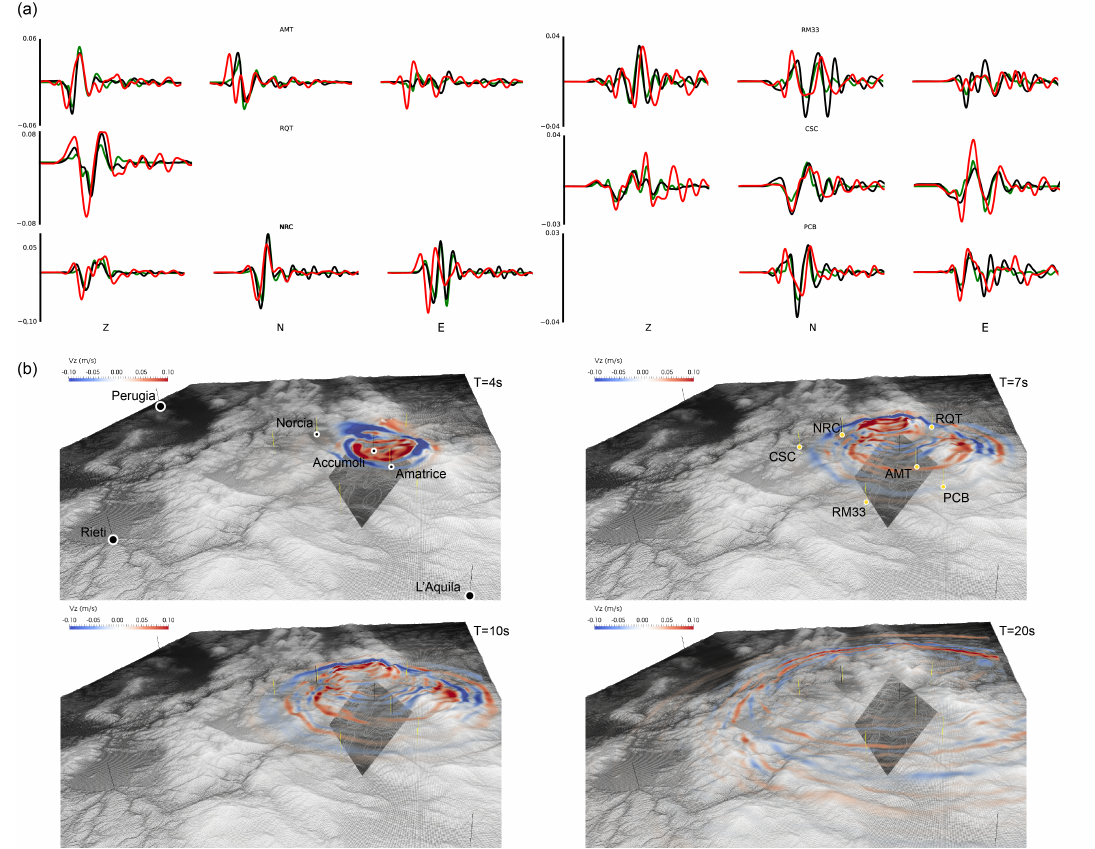
Figure 2: a) Velocity history at selected stations (AMT, RQT, NRC, RM33, CSC, PCB). Black are the observed data, red are our 3D synthetic seismograms and green the 1D synthetic seismograms generated by [Tinti et al.(2016)]. b) Snapshots of the vertical component of the seismic velocity wavefield viewed from